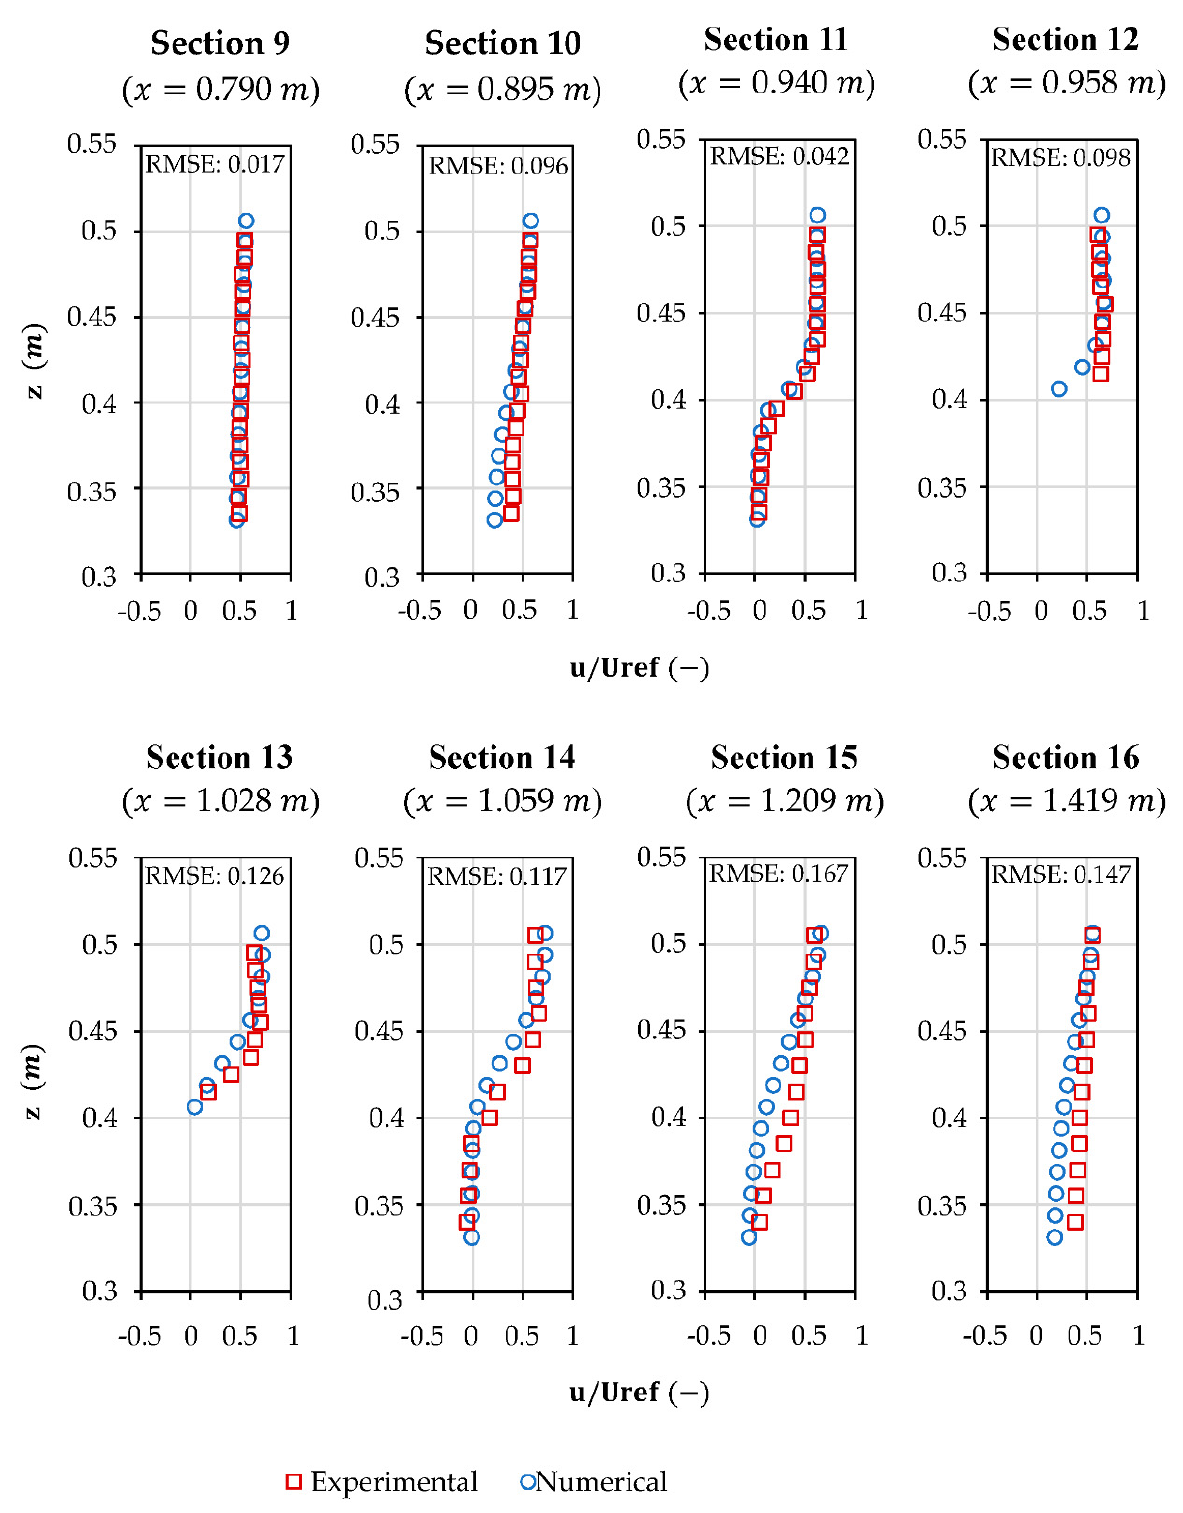
Figure A5. Comparisons between the wind-tunnel measurements performed by Leitl and Schatzmann [28] and the numerical model predictions of the horizontal velocity profiles derived from eight different sections locating on a near-surface plane, y = 0.035 m. The comparisons are performed for the right half side of the domain, where the building centreline and the lateral face of the building are located at z = 0.325 m and z = 0.400 m, respectively.